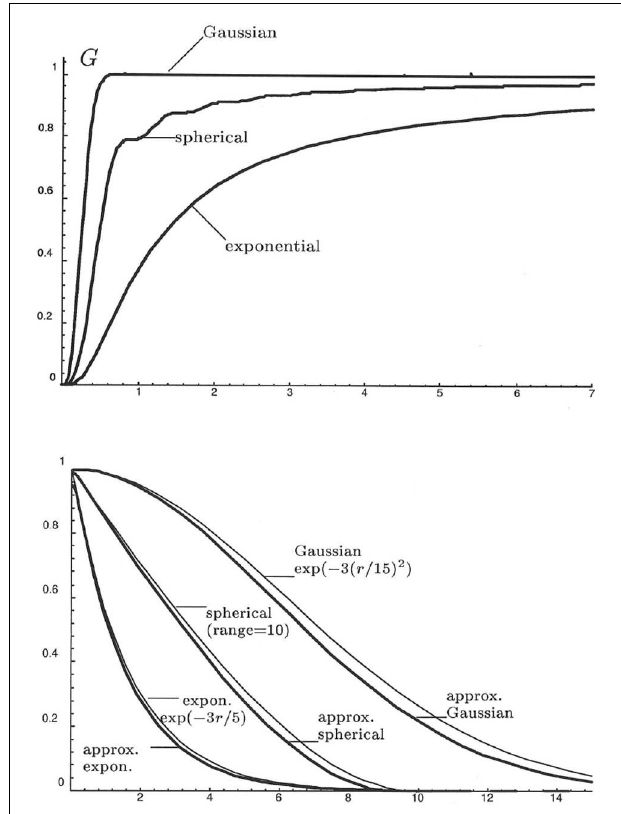
FIGURE 1 | Above: Polar spectral distribution functions. Below: Corresponding correlation functions and their approximations.